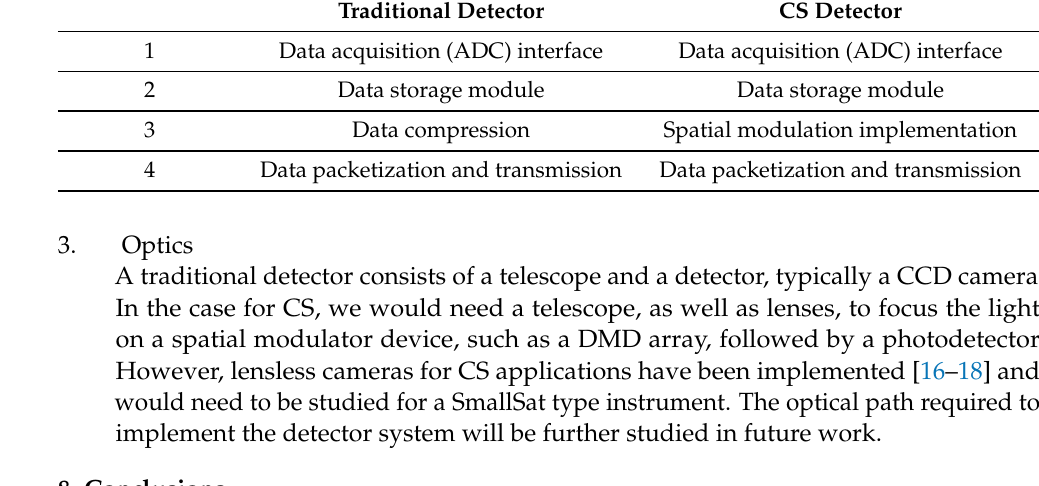
Table 13. FPGA modules comparison for a traditional detector and CS based detector. Traditional